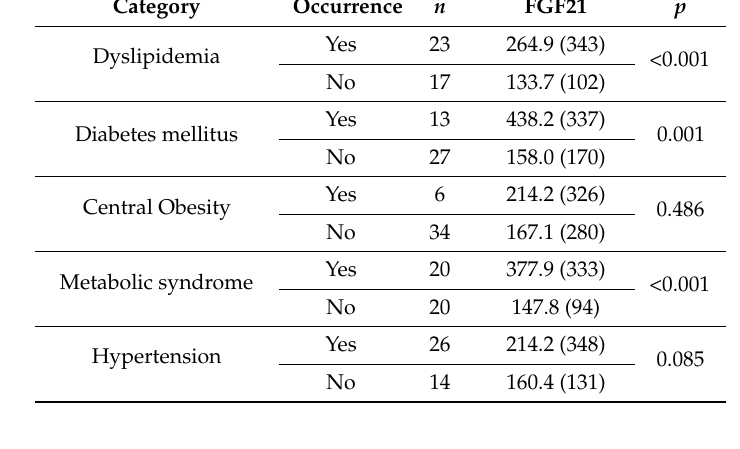
Table 4. FGF21 levels in PPGL patients with metabolic syndrome and its components.